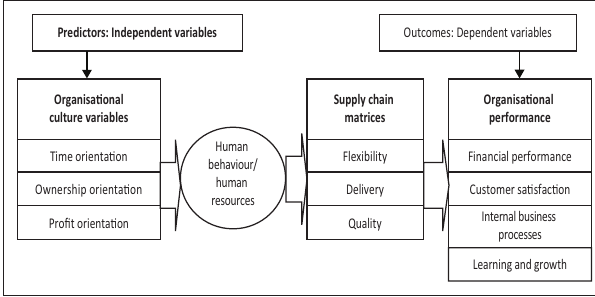
FIGURE 2: Conceptual